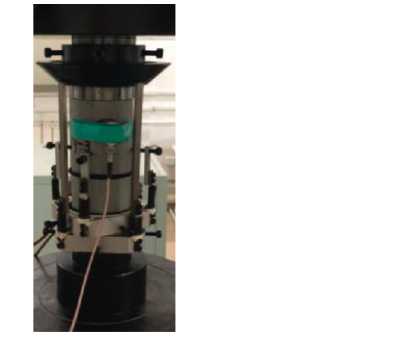
Figure 10: Loading of the uniaxial compression